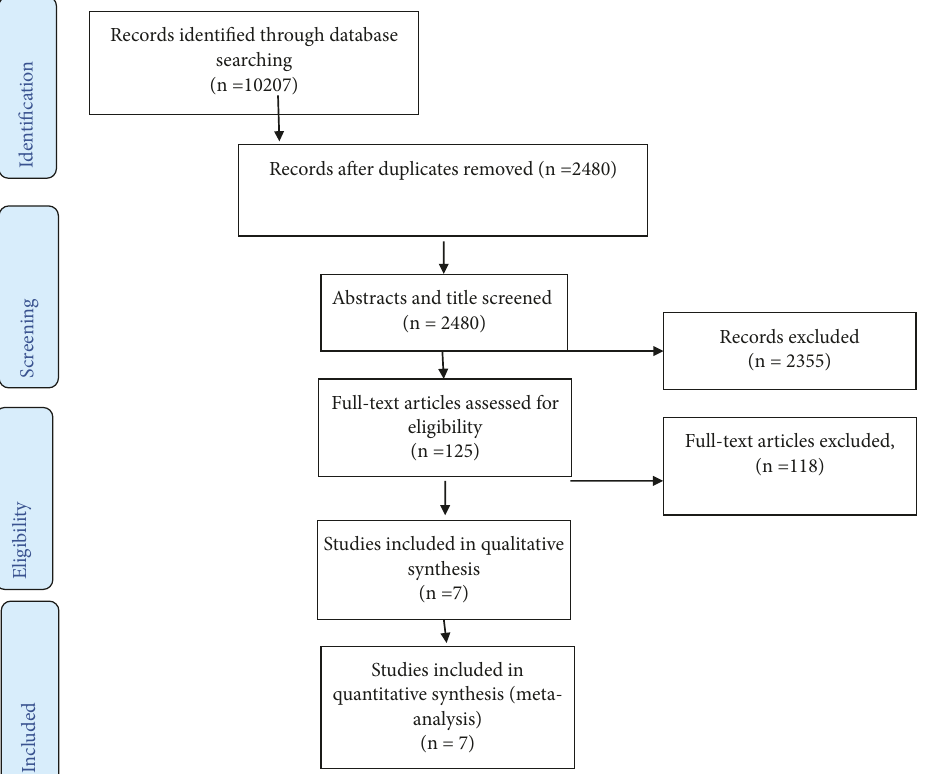
Figure 1: Flow chart to describe the selection of studies for the systematic review and meta-analysis of the prevalence of malaria among pregnant